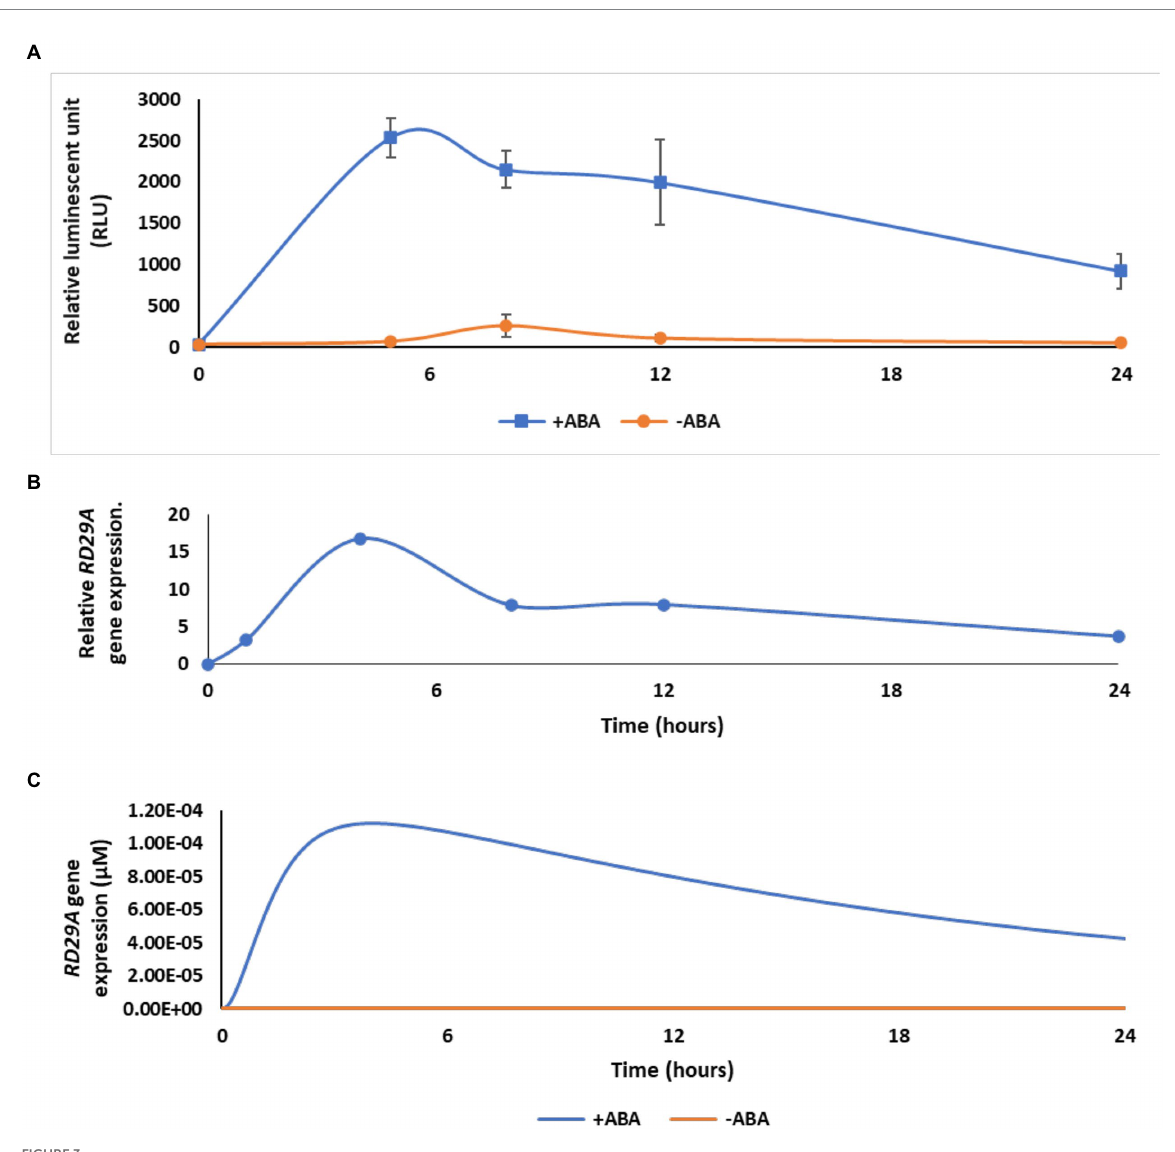
FIGURE 3 The dynamic model agrees with ABA-induced gene expression in real plants after optimization. (A) Kinetics of luciferase activity in the RD29A::LUC plant after exposure to 200 μ M ABA (+ABA) or DMSO for control (-ABA). The graph shows the mean of three independent experiments. Error bars represent standard error from the mean. (B) Kinetics of RD29A gene accumulation in the previously published data with 10 μ M ABA in Arabidopsis (Song et al., 2016). (C) Model output with showing transient expression after optimization of parameters kf26, kf27, and